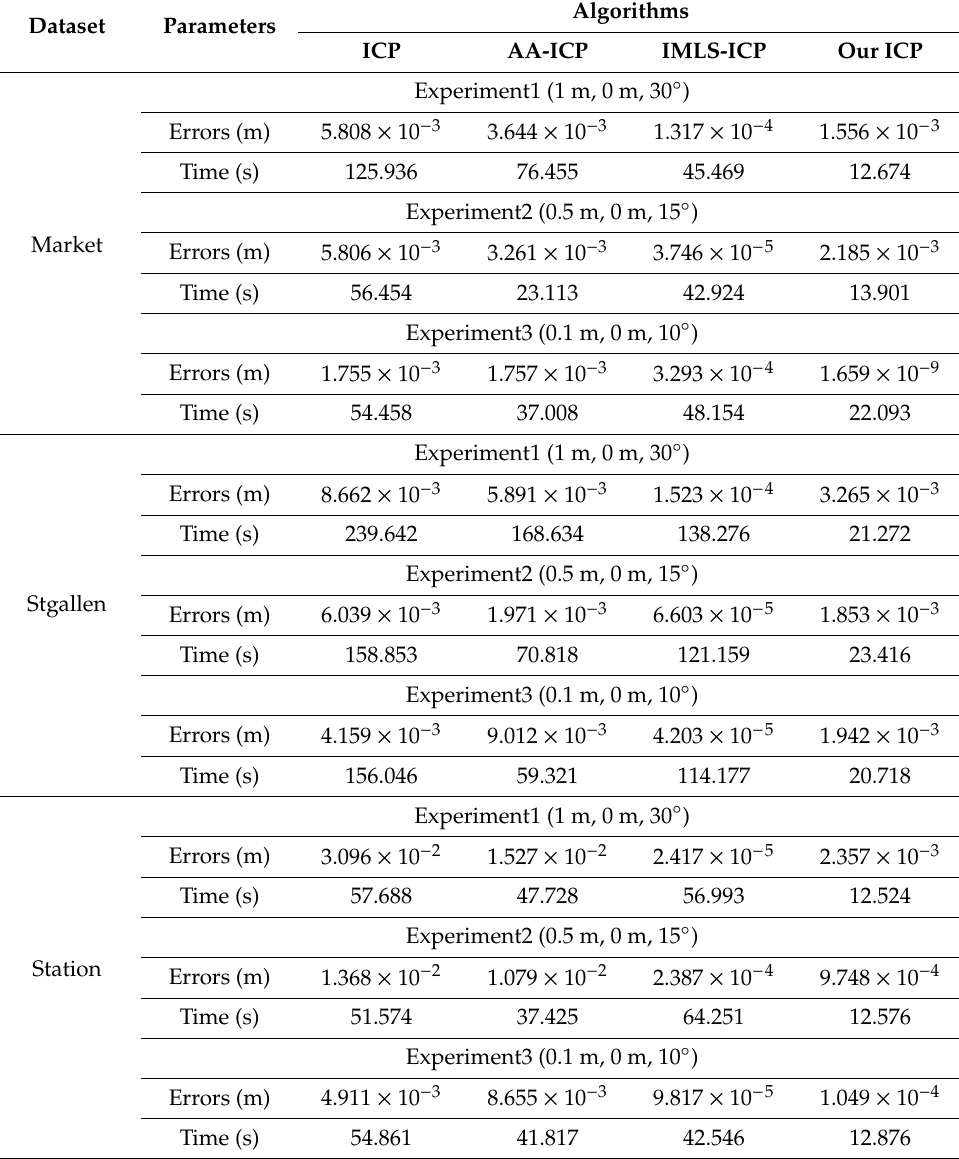
Table 1. Comparison of the speed and accuracy of four ICP algorithms.